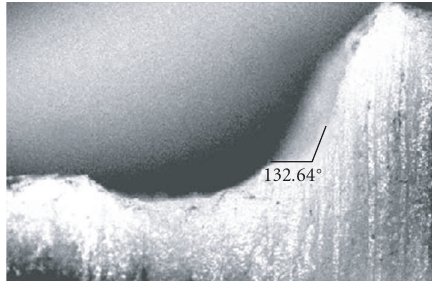
Figure 2: Image on profile projector for group B.